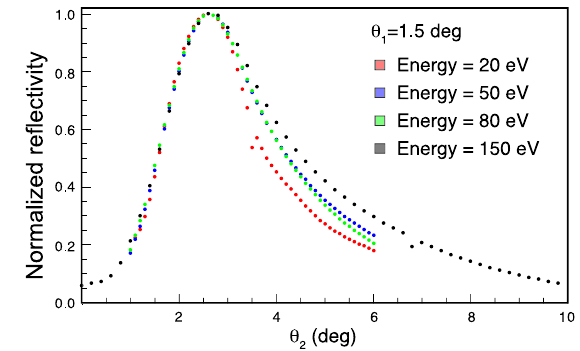
FIG. 19. Observed reflectivity, as a function of energy, alumi- num sample #2, for the cases listed in Tab V.